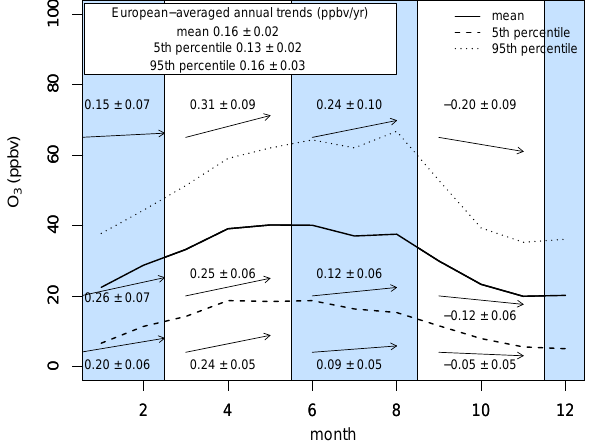
Fig. 8. The average European seasonal O 3 cycle for mean, 5th Fig.8. TheaverageEuropeanseasonal O 3 cycleformean,5thand95thpercentiles. Annotationsdisplaythestatisticallysignificant(p < and 95th percentiles. Annotations display the statistically signifi- 0.1)European-averagedseasonal(winter,springsummer,autumn)andannualtrendsinppbv/yr(2 σ errors) cant ( p < 0.1) European-averaged seasonal (winter, spring summer, autumn) and annual trends in ppbvyr − 1 (2 σ errors).